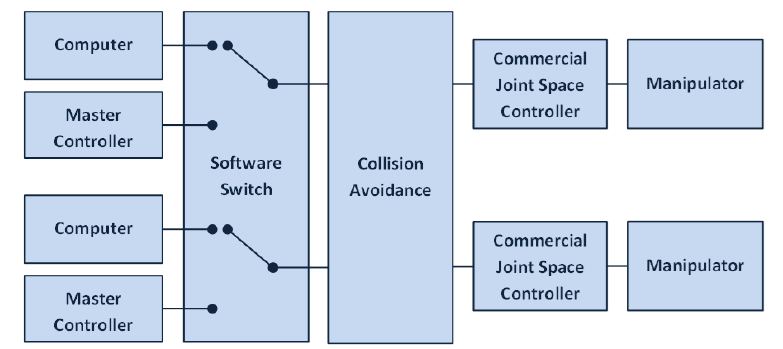
Figure 1. Block diagram of a dual manipulator control